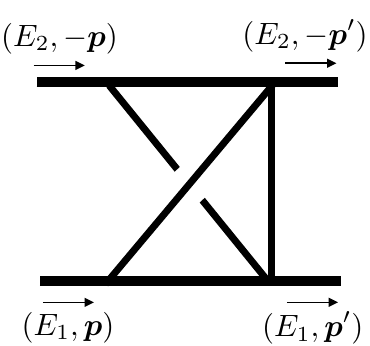
Figure 20 . The nonplanar version of the double-triangle prime diagram.